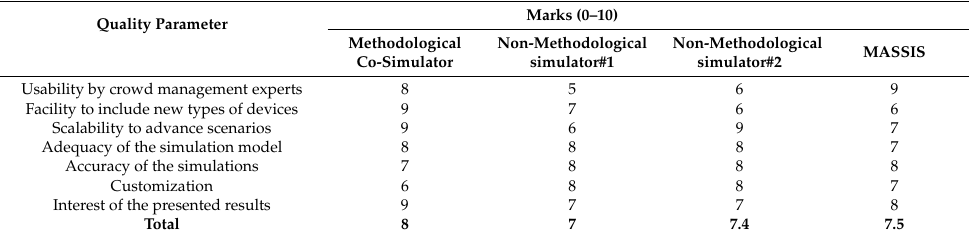
Table 11. Results about the quality parameters in the first experiment.